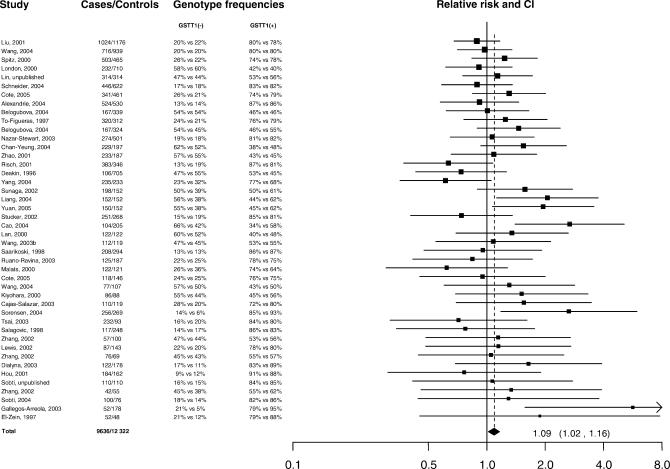
Meta-Analysis of Studies of
GSTT1 Polymorphism and Lung Cancer
The horizontal axis is plotted on a log doubling scale.